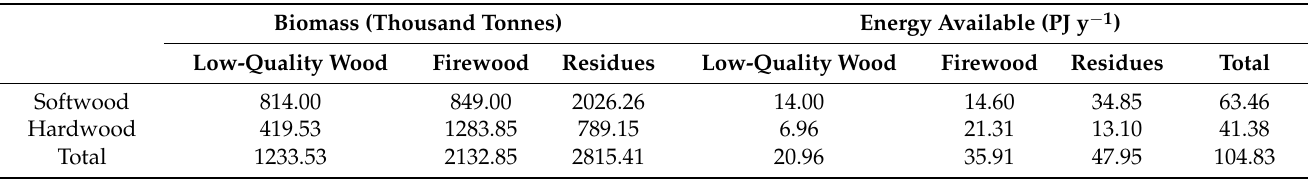
Table 4. Energy available yearly from wood biomass in State Forests in